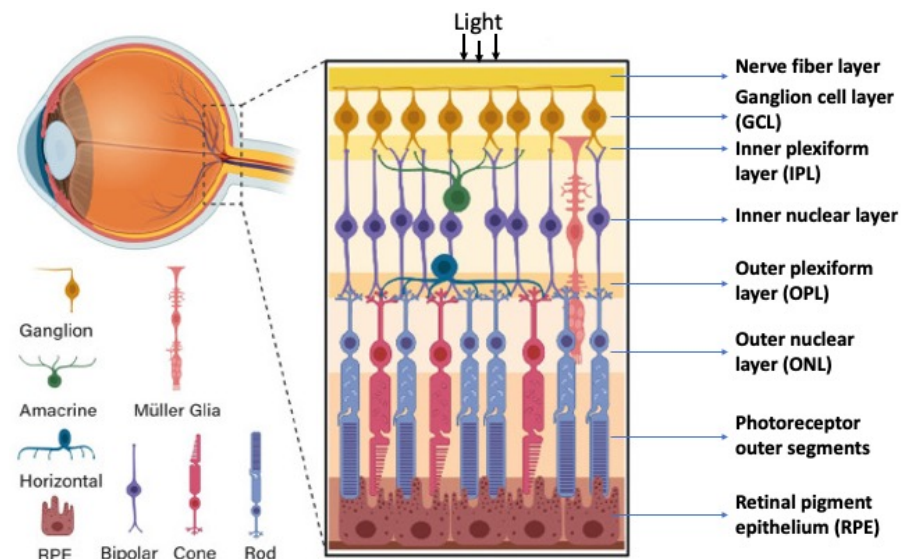
Figure 1. The structure of the retina and its main cell types. Schematic diagram (BioRender, https://app.biorender.com/).